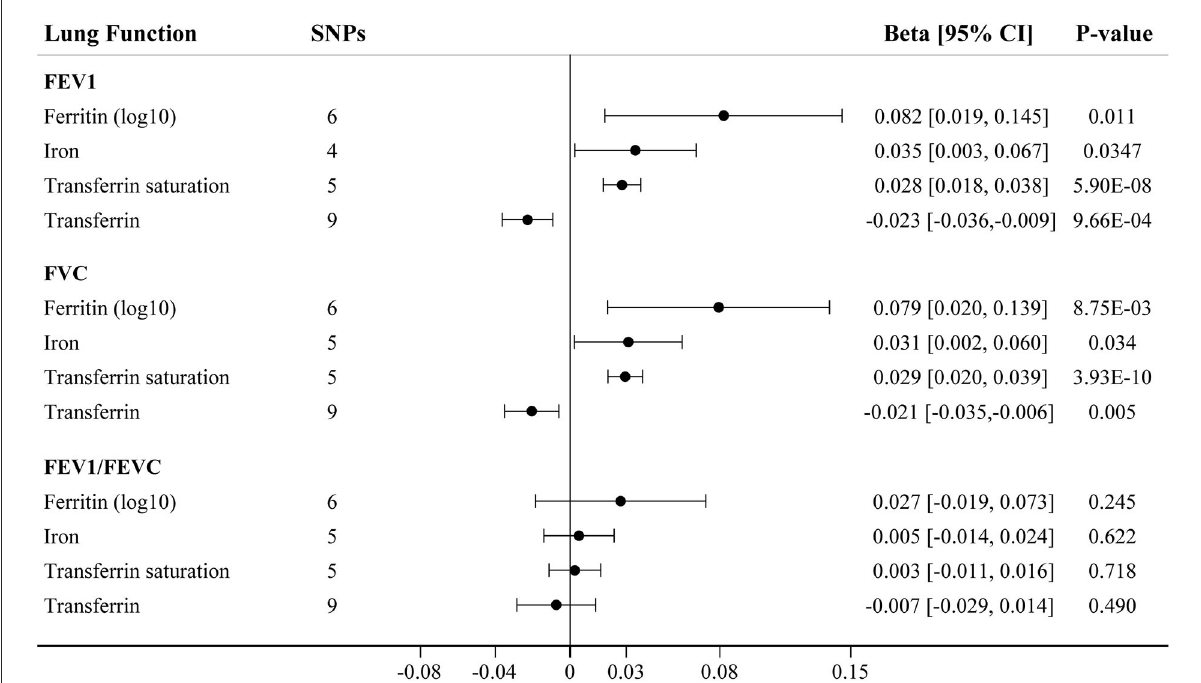
FIGURE3 The IVW MR estimates for relationship between iron status and lung function using liberal instrumental variables associated with each iron biomarker. The causal effects of iron status on levels of FEV1, FVC, and FEV1/FVC ratio are estimated. Results are reported as beta with corresponding 95% CI per SD unit increase in each iron marker. IVW, inverse variance weighted; MR, Mendelian randomization; FEV1, forced expiratory volume in 1s; FVC, forced vital